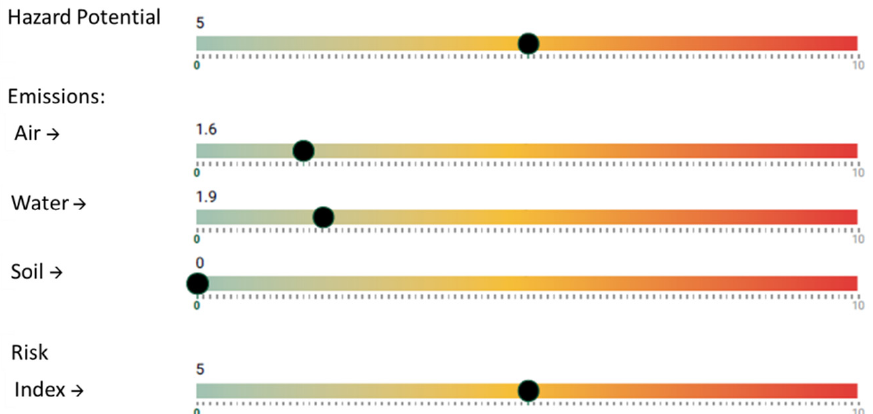
Figure 8. Excerpt from the report generated with the NanoSerpa v1.0 app for the release of TiO 2 nanopowder from a bag filter system. These results apply only to the exposure area where the events studied have occurred.